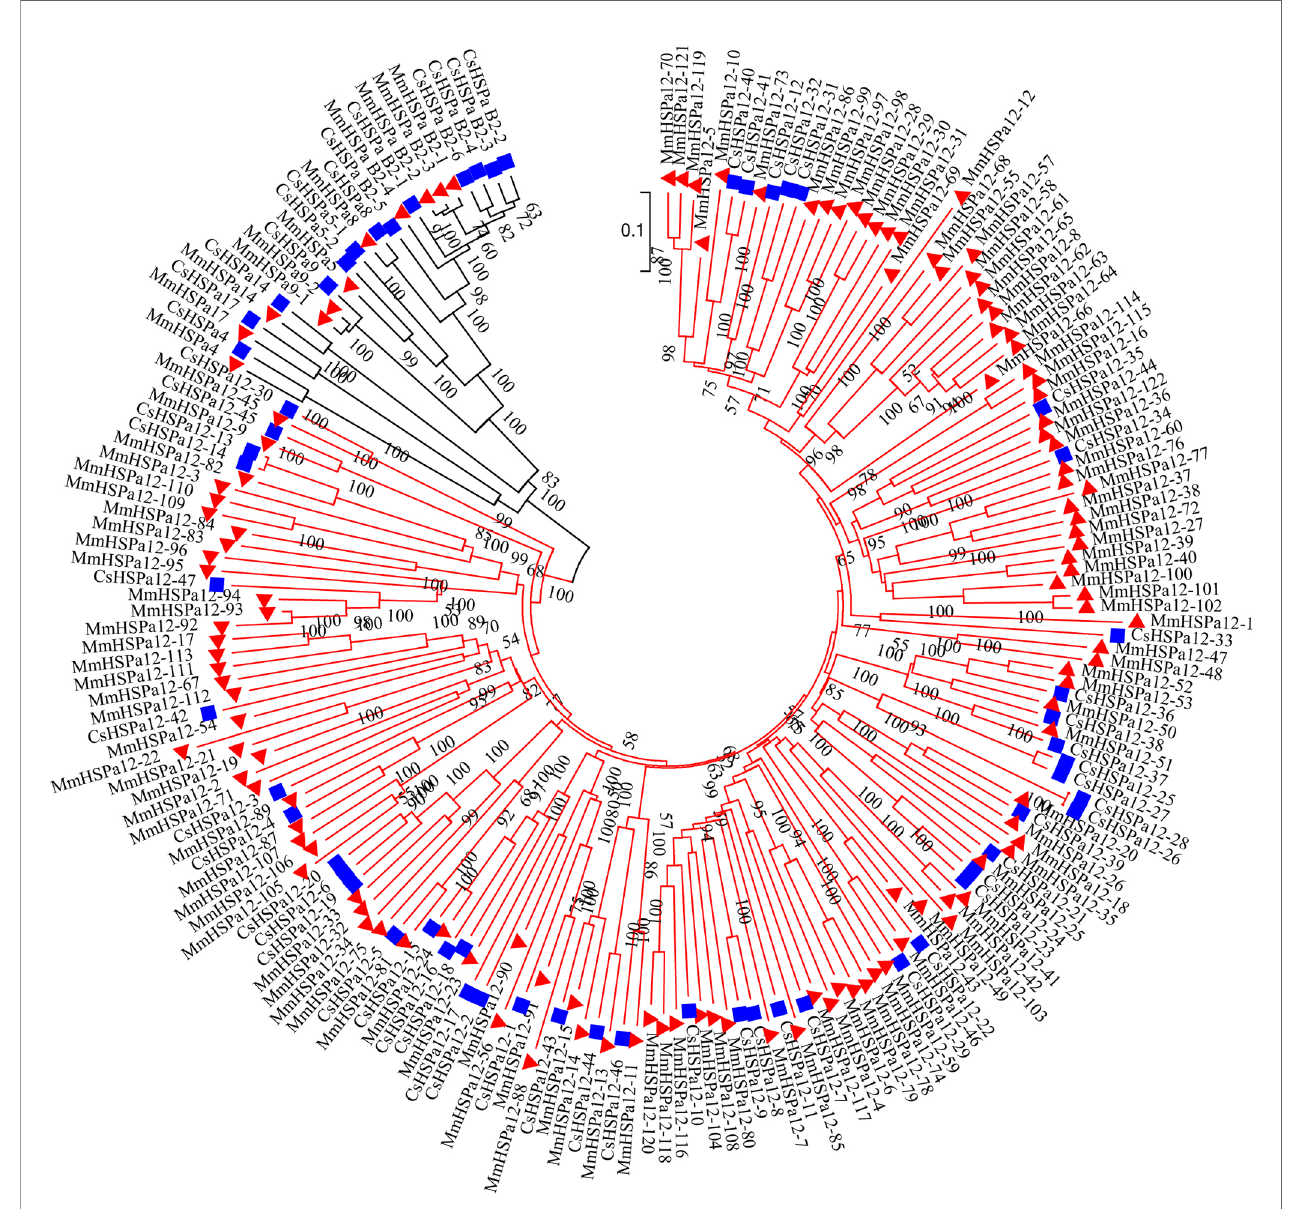
FIGURE 5 | Phylogenetic analysis of 193 clam HSP70 protein sequences (133 M. mercenaria HSP70 and 60 Cyclina sinensis HSP70 protein sequences). M. mercenaria HSP70s and C. sinensis HSP70s were marked with red triangles and blue squares, respectively. The HSPa12 branches were highlight in red. Support value was assessed using bootstrapping (100 pseudoreplicates), if value was less than 50, the data was not